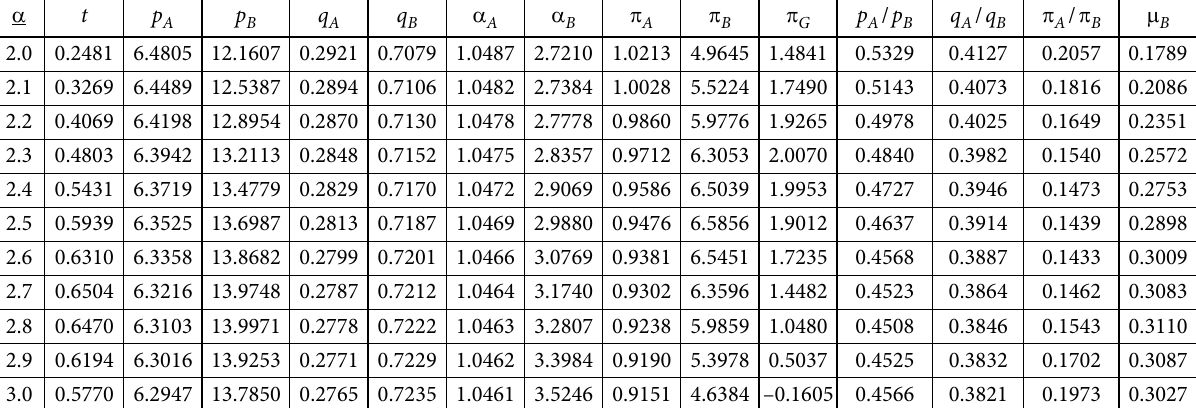
Table 3. Dynamic changes of all the factors caused by changes in minimum assembly rate for government subsidy a